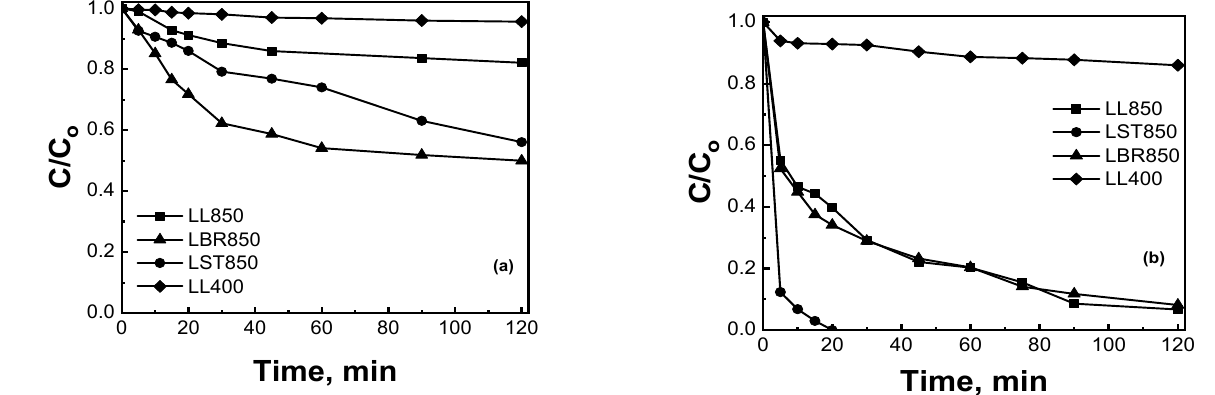
Figure 6. Removal of 0.5 mg L − 1 SMX 100 mg L − 1 BC under ( a ) adsorption and ( b ) oxidation with 500 mg L − 1 SPS in UPW and inherent pH.